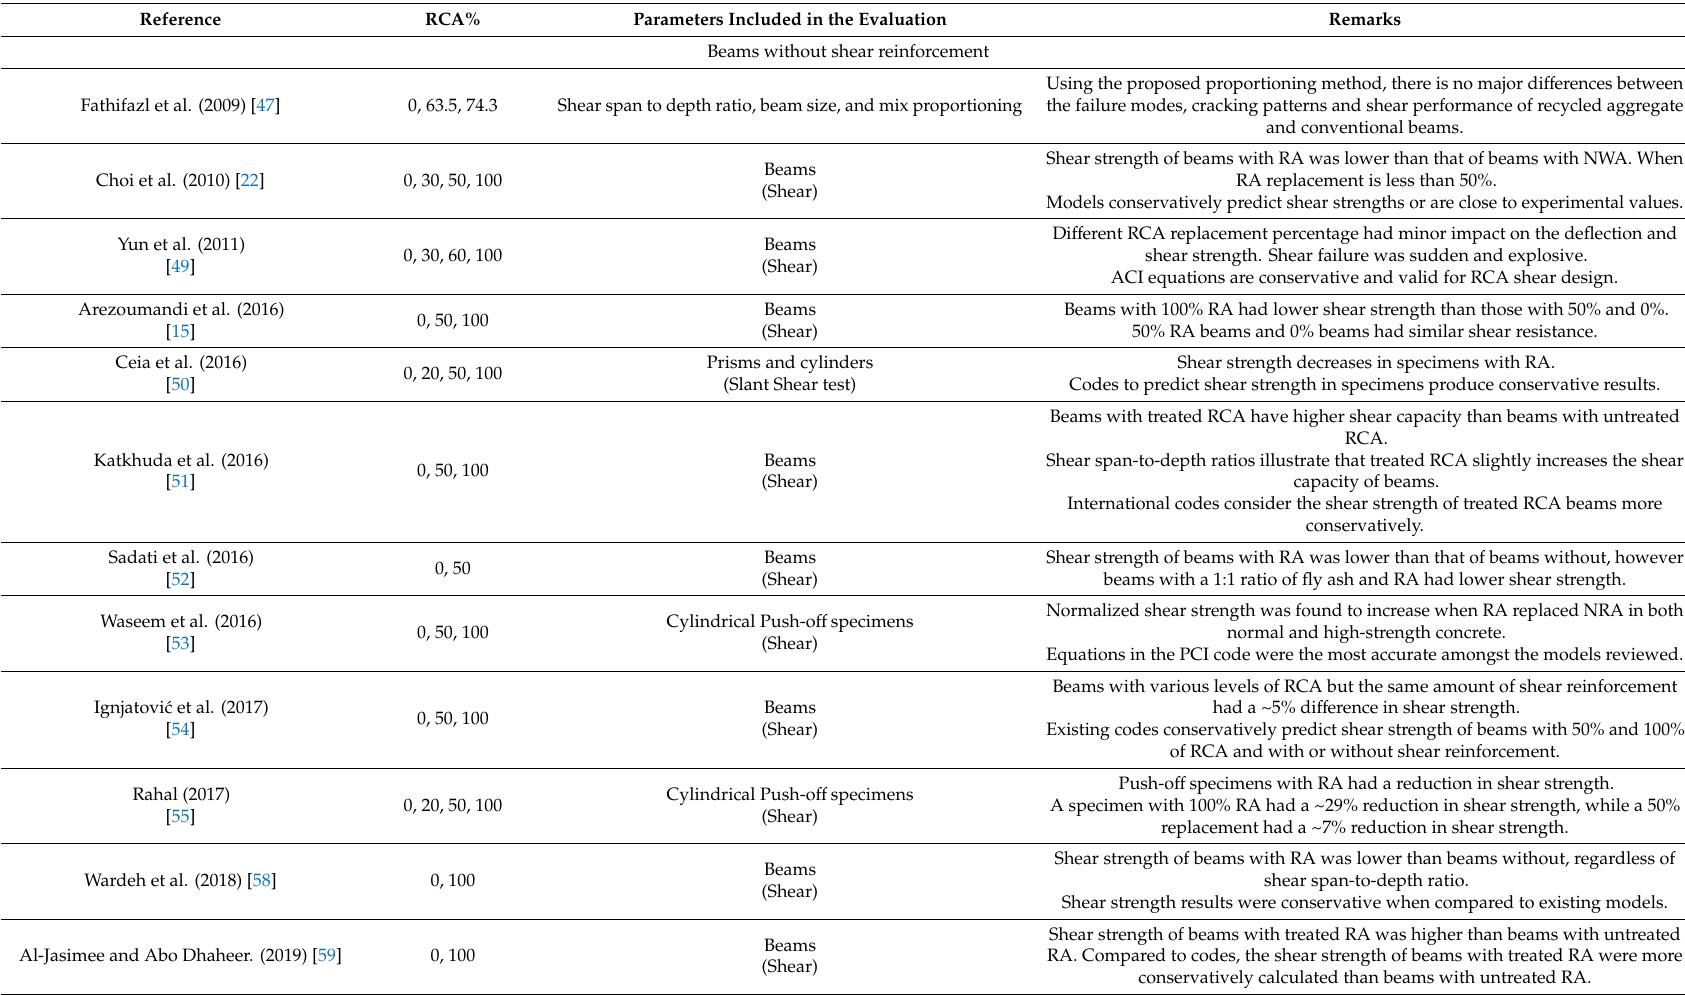
Table 1. Shear capacity of recycled concrete aggregate (RCA) with / without fiber